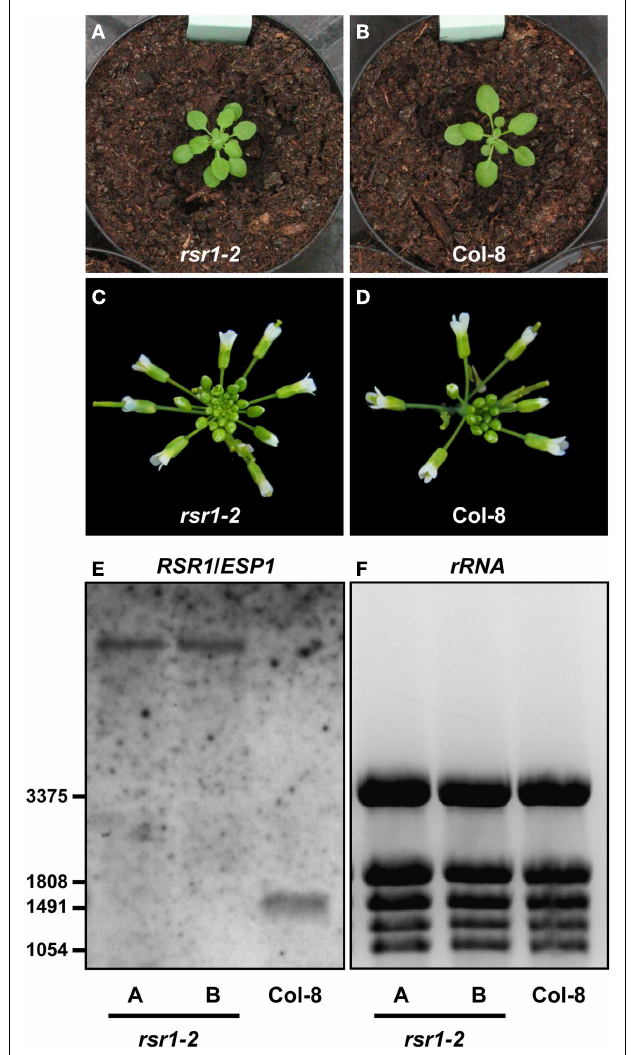
FIGUREA1 | Organ initiation rate is increased in rsr1-2 . (A,B) Rosettes of rsr1-2 plants had approximately 1.5 times more leaves than Col-8 plants of the same age. (C,D) Also inflorescences of rsr1-2 contained higher numbers of buds, resulting in more open flowers per day. (E) By northern blot, no native RSR1 / ESP1 transcripts (expected size 1455b) were detected in homozygous rsr1-2 plants. (F) EtBR stained rRNA confirms equal loading of the gel. rRNA bands were also used as size